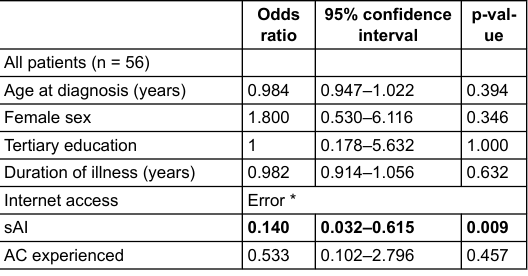
Table 7: Factors contributing to a good test performance in Part A.